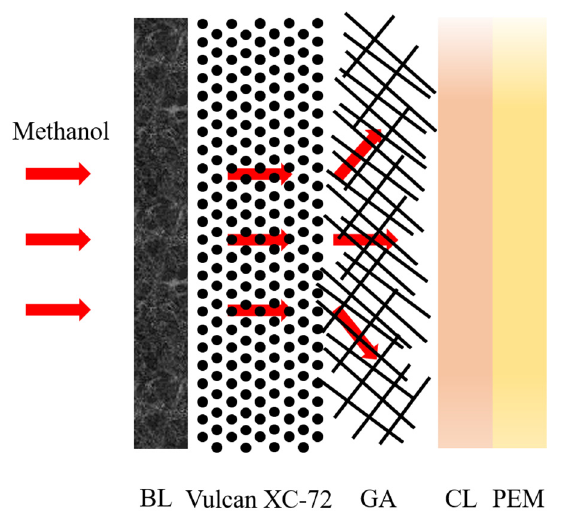
Figure 7. Schematic diagram of methanol transport process through the tortuosity engineered dual-microporous layer electrode.